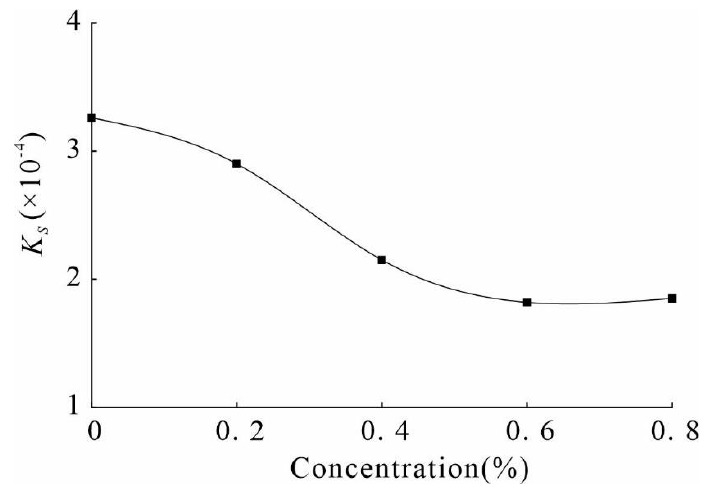
Figure 6. Ks of different stabilizer concentrations.